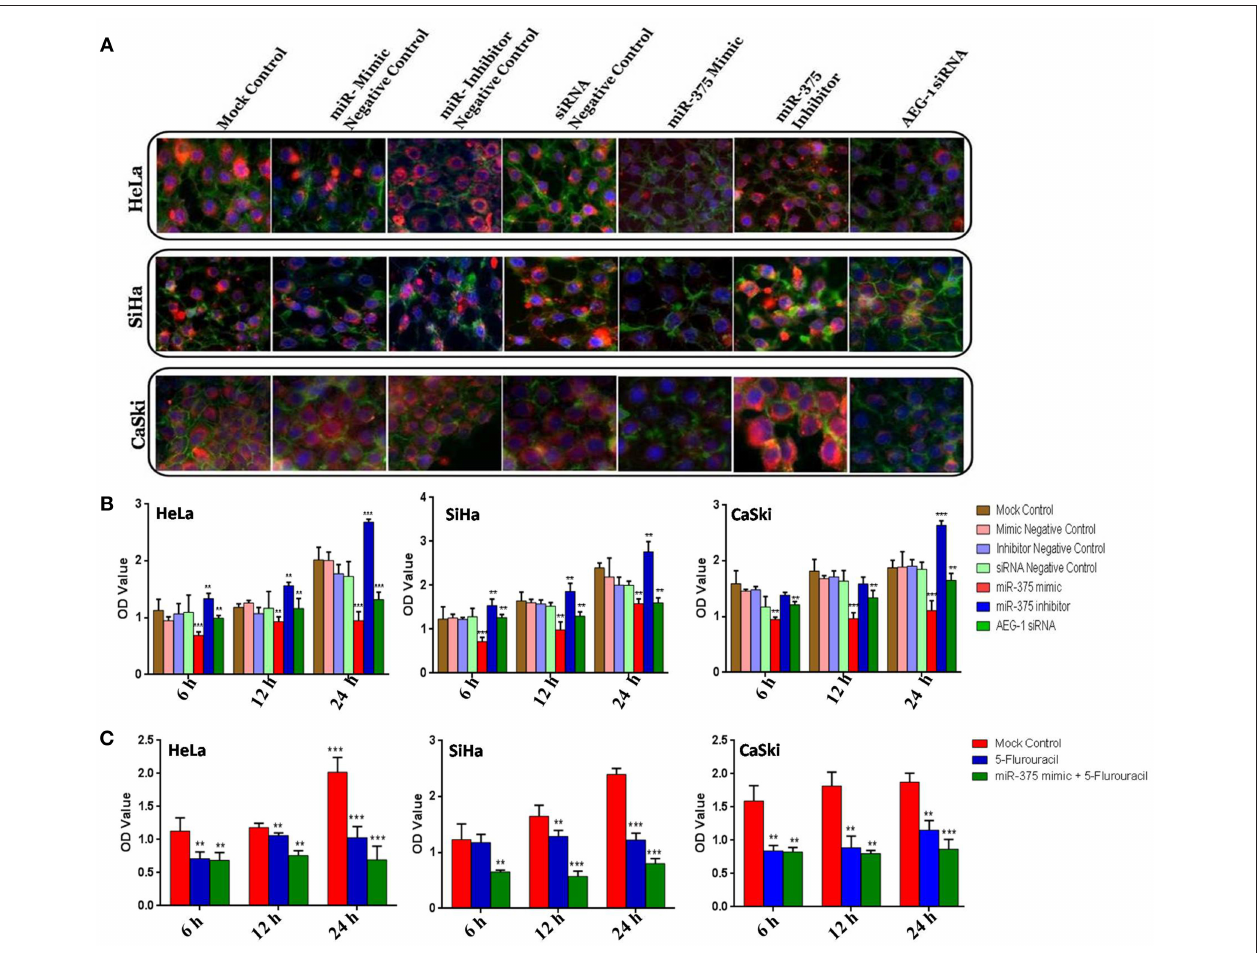
FIGURE 5 | miR-375 inhibits cellular proliferation, enhance 5-Fluorouracil sensitivity and Immunocytochemistry in CC cells. AEG-1 Protein expression was determined by Immunocytochemistry (A) . Effect of miR-375 mimic on CC cells proliferation of by MTT assay (B) . CC cells were transfected with a mock control, miR-375 mimic and then the miR-375 transfected cells were treated with IC 50 Value of 5-Fluorouracil and incubated at different time intervals (6, 12, and 24h) (C) . The scale bars represent 100 µ m. Error bars represent mean ± s.d. and P- values are represented as ** P < 0.05, *** P < 0.001 compared to the corresponding